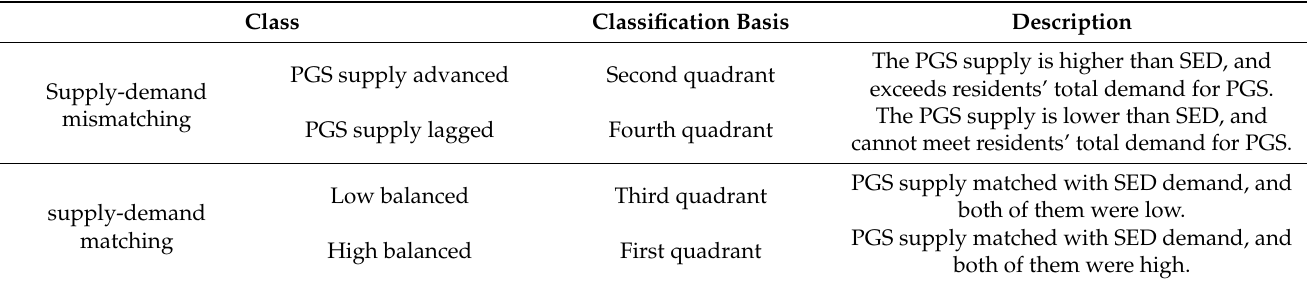
Table 3. Classification of PGS-SED supply-demand